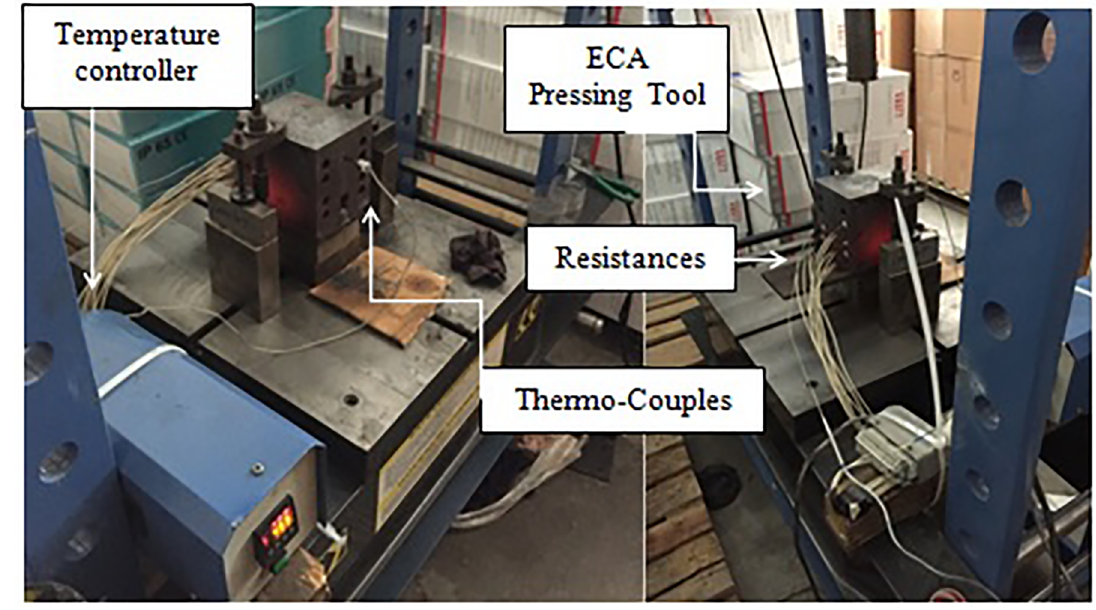
Figure 3. Tensile Specimen Geometriy Table 1. Experimental design with Taguchi L27 and output values of